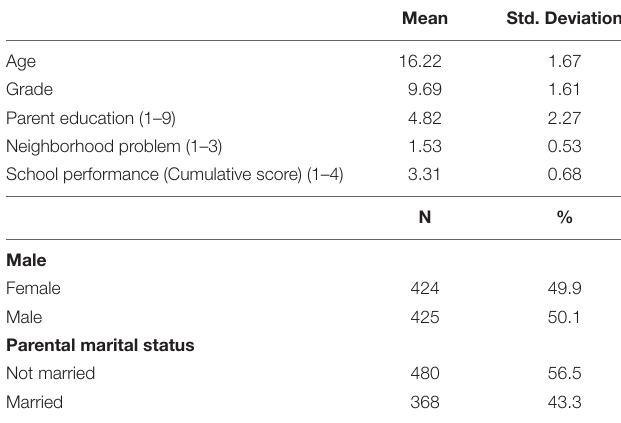
TABLE 1 | Descriptive statistics in the overall sample ( n =